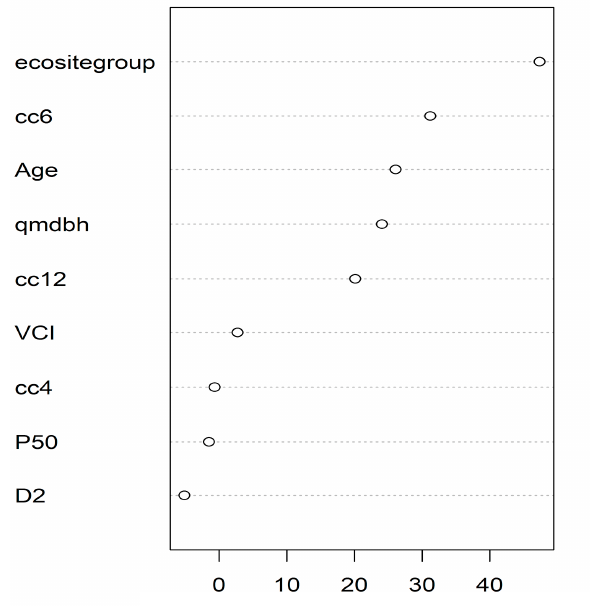
Figure 9. Variable importance as a percentage increase in mean squared error (MSE) for random forests model predicting mean density (kg·m − 3 ) for black spruce increment core samples in the Hearst Forest (n = 109).